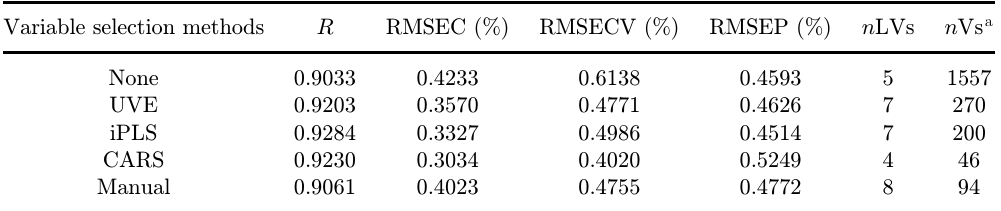
Table 4. Model results with di®erent variable selection methods.